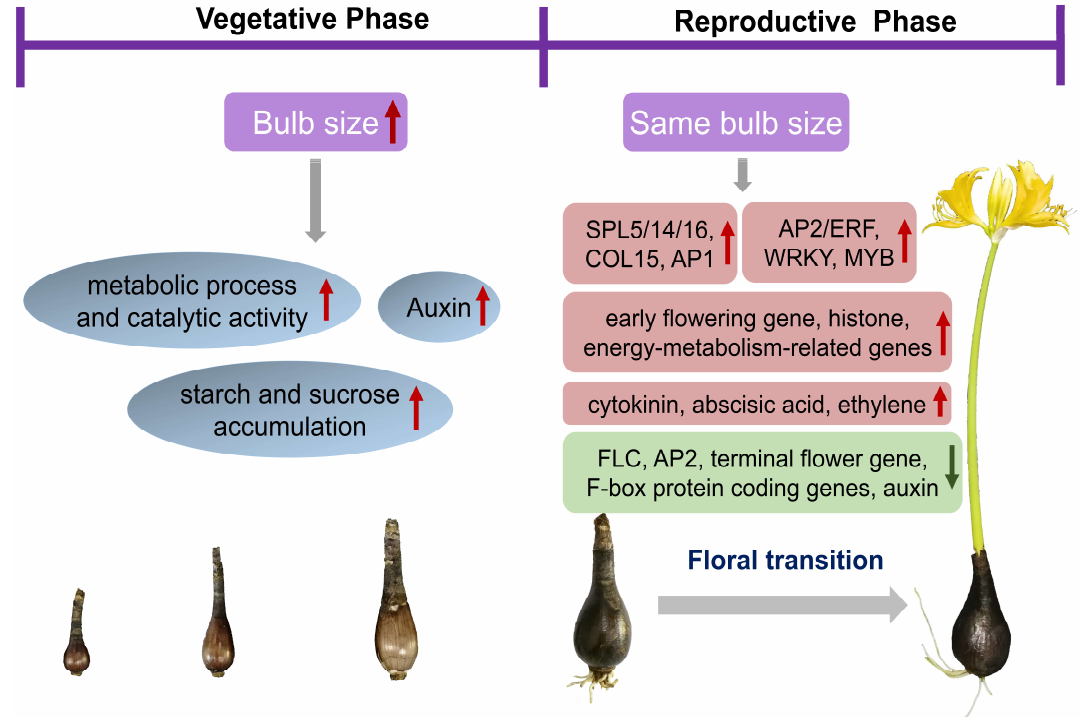
Figure 8. Hypothetical model for the regulatory networks of bulb growth and flowering in Lycoris chinensis . Up and red arrows indicate increased or upregulated expression, down and green arrows indicate downregulated gene